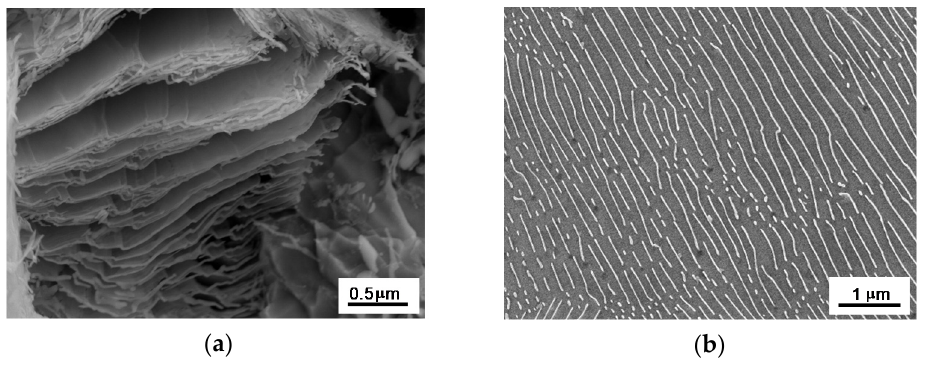
Figure 8. Presence of kinks along the cementite lamellae (revealed by deep nital etching) ( a ), and detail of the lamellae break-up initiation due to the kink zone dissolution after the application of a short annealing at 600 °C ( b ) in the coarse pearlite.